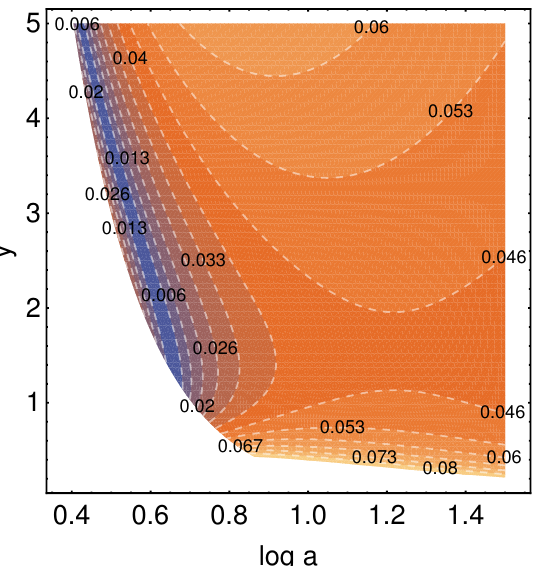
Figure 6 . AC model. We show the relative difference r = | Λ 0 2 axis) and y ( y axis). Notice the minima for log a ’ 0 . 4 − 0 . 6 .